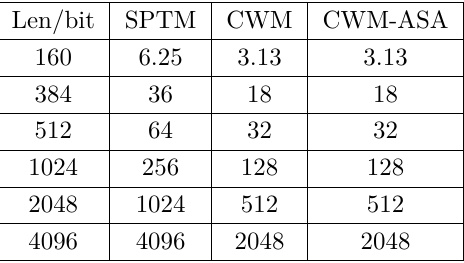
Table 5: Memory usage (in KiB) of the proposed